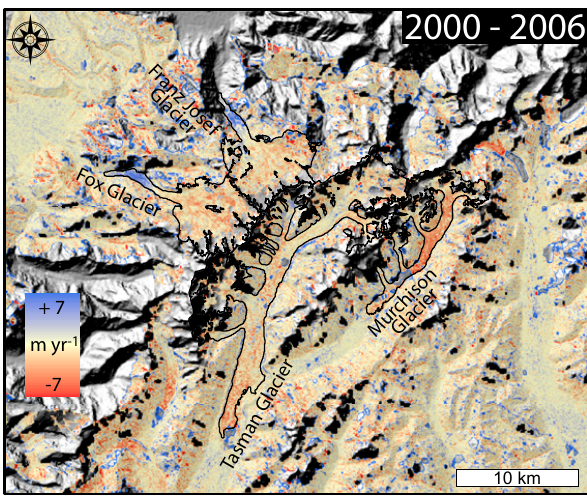
Fig. 7. Elevation changes from 2000 to 2006 on the Fox, Franz Josef, Tasman and Murchison glaciers. Only six year changes are shown due to their level of significance. Fox and Franz Josef glaciers show slight thinning at upper elevations and thickening at the glacier fronts, while the Tasman and Murchison glaciers expe- rience slight thinning that is at the limits for significant detection using these datasets.